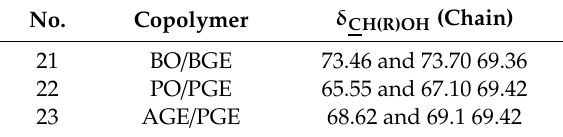
Table 7. 13 C NMR chemical shifts (in ppm) of terminal carbons present in copolyether-diols.